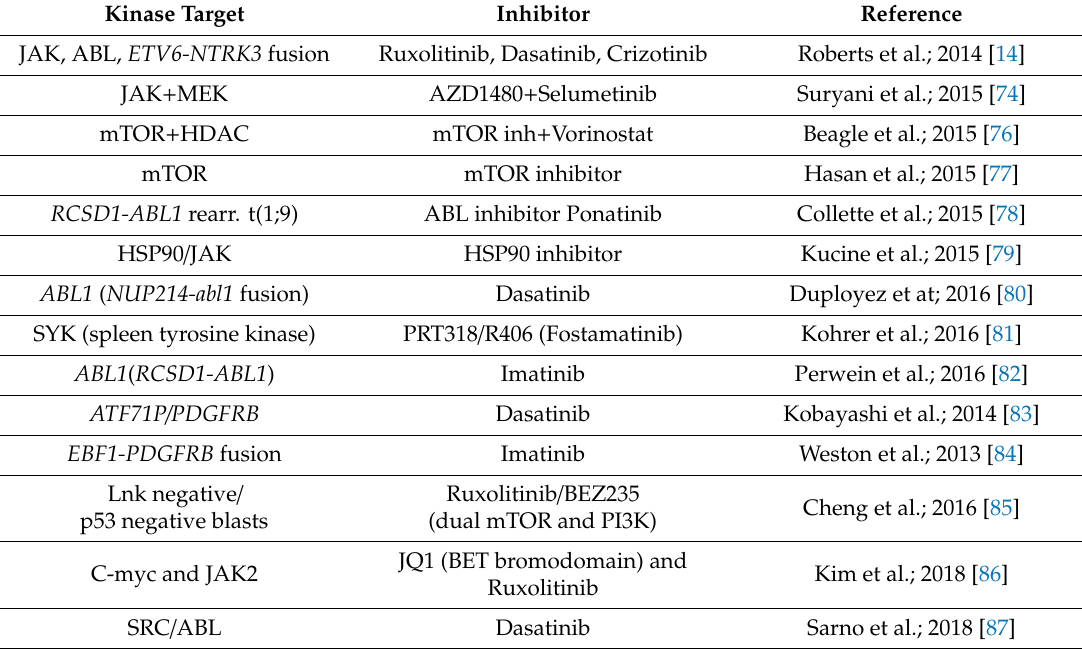
Table 2. Preclinical studies identifying kinase mutations and targeting with kinase inhibitors in Ph-like